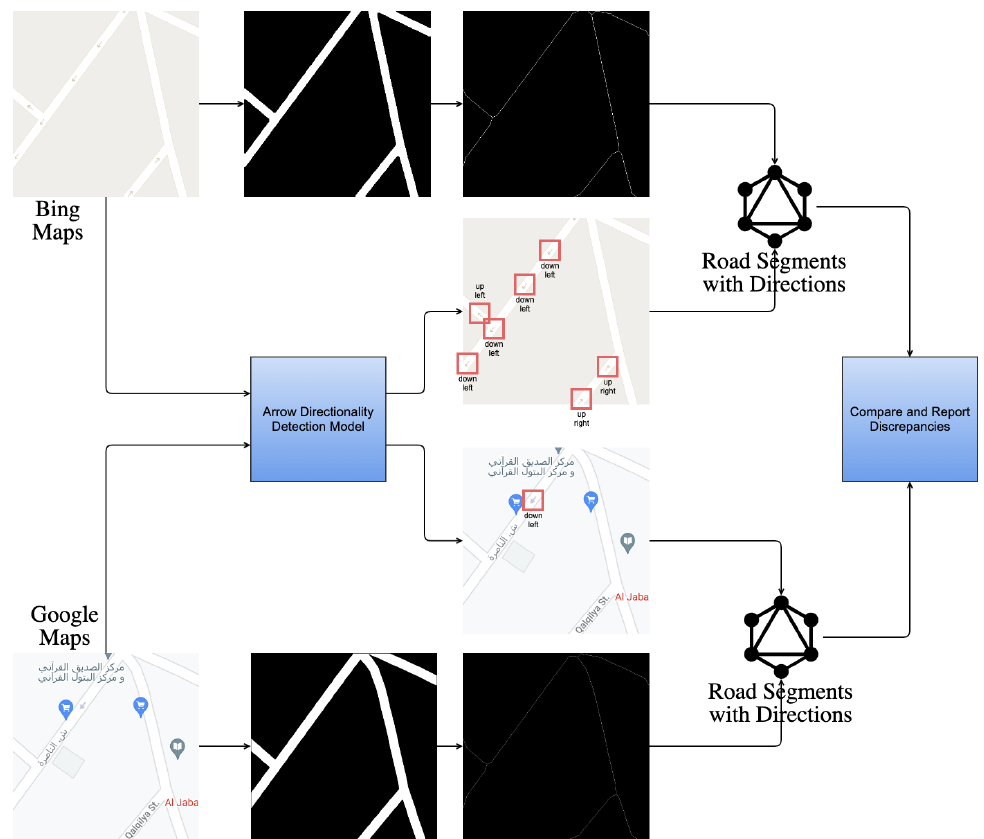
Figure 16. Road network generation architecture.